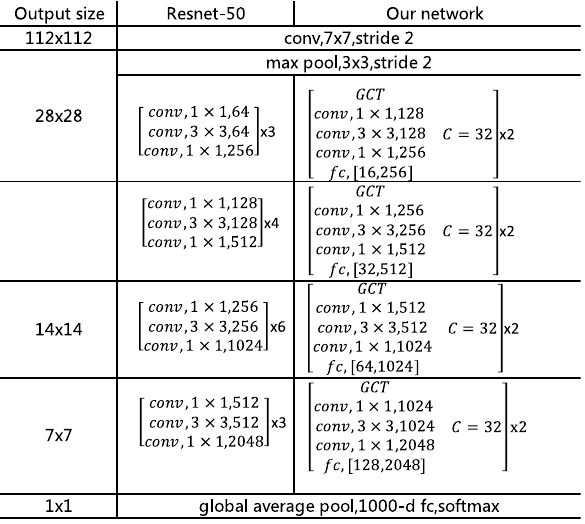
Fig. 4 (Left) ResNet-50. (Right) Our